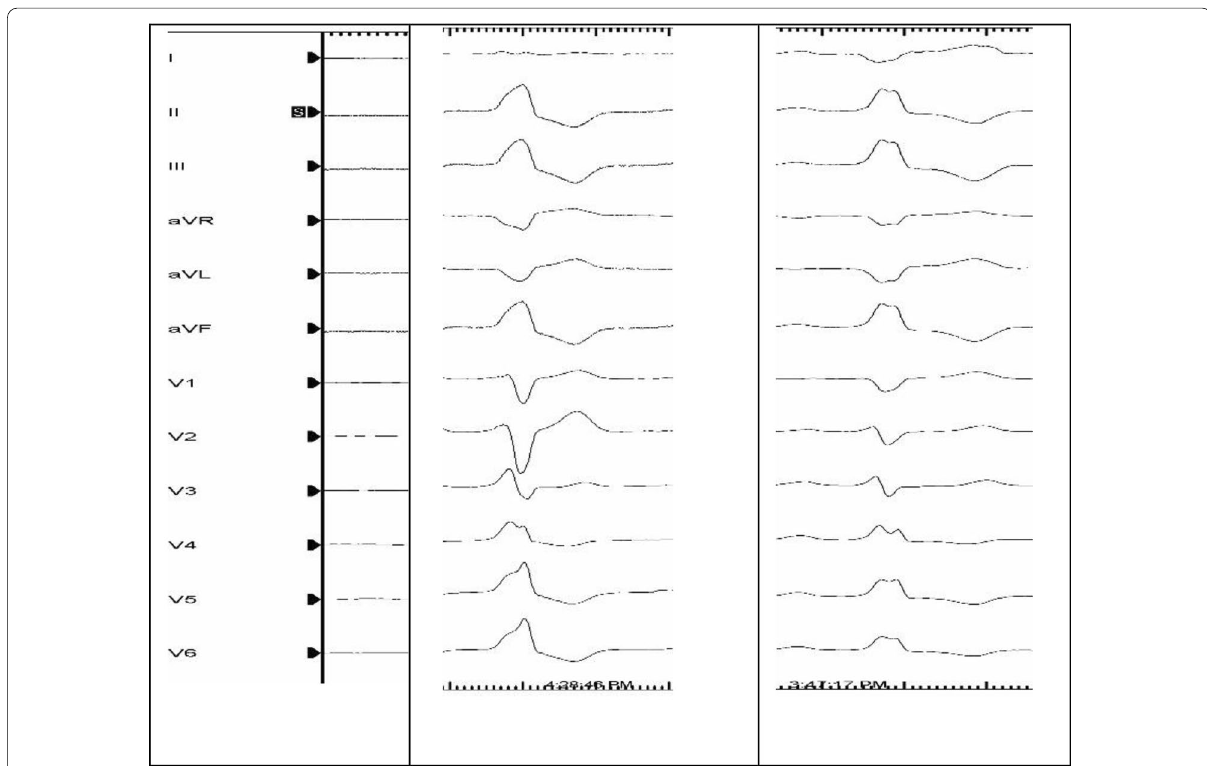
Fig. 1 Left and right panel ECGs showing a septal vs free wall origin of the RVOT ectopy based on Ito algorithm. In both panels, PVCs are characterised by a LBBB morphology with late transition in V4 and R / S ratio > 1 in lead II, III and AVF. The presence of QRS notching and the lower R wave amplitude in the inferior leads is highly suggestive for a free wall origin as in the right panel. Absence of QRS notching and higher R wave amplitude in the inferior leads suggest a septal origin of the PVC